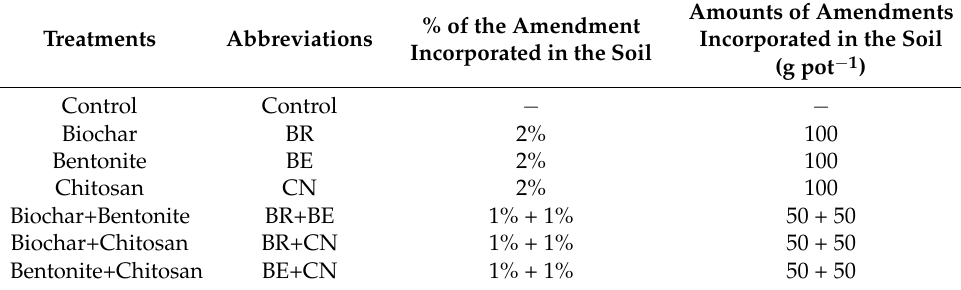
Table 1. Overview of treatment plan considered in this pot